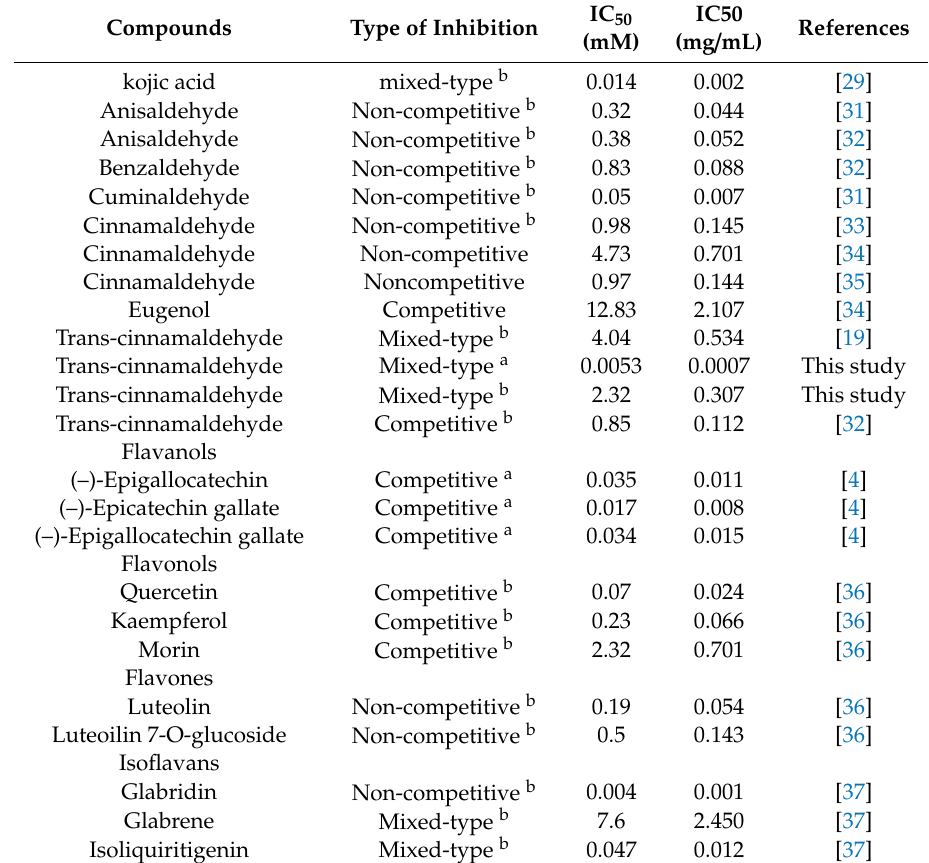
Table 1. Summary of the tyrosinase inhibitory activity of compounds from natural sources.